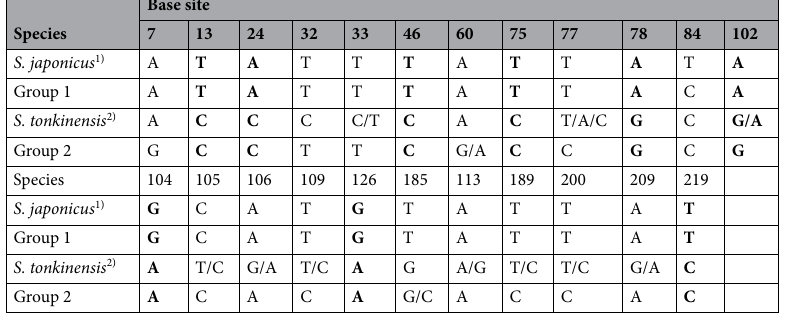
Table 3. BLAST comparison of base difference sites of ITS2 sequences from Styrax Linn. samples with S. japonicus and S. tonkinensis . 1) S. japonicus has the following accession numbers in Genbank: AB114900, LC534305, LC600960, and MF349070; 2) S. tonkinensis has the following accession numbers in Genbank: JF421547, MF096782, MF096783, MF096784, MF096785, and MF096786. Group 1 is the 14 samples identified as S. japonicus and group 2 is the 16 samples identified as S. tonkinensis . Bolded black indicates differential loci for S. japonicus and S. tonkinensis.